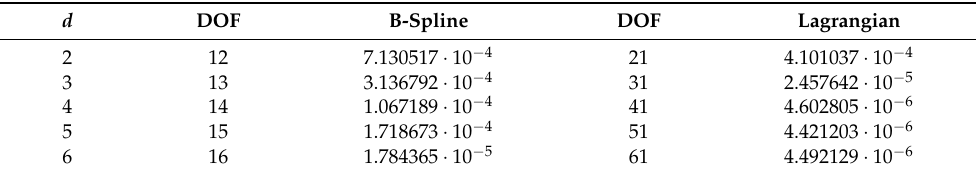
Table 9. Relative error in H 0 ( Γ ) norm at final time T = 300 for B-spline and classical Lagrangian shape functions of different degrees, having fixed space discretization step ∆ x = 0.2 and time-step ∆ t =